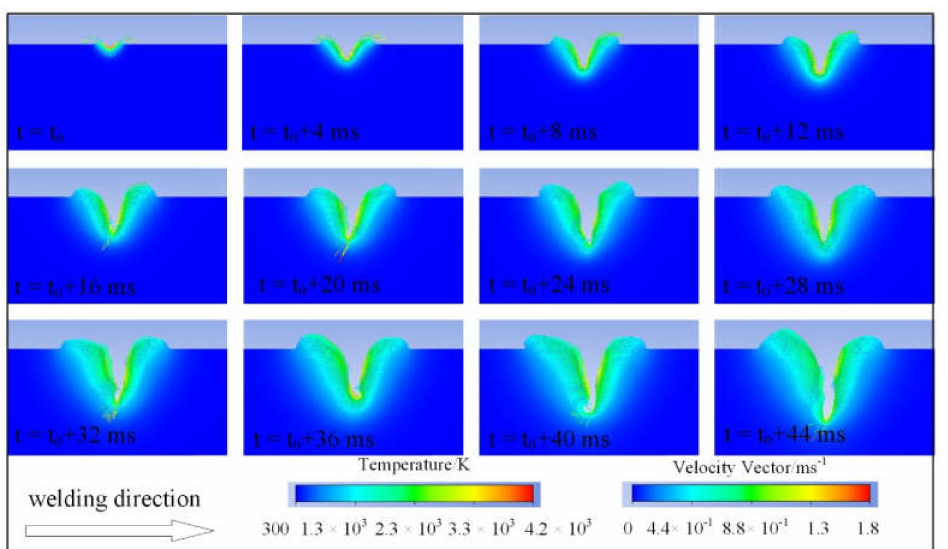
Figure 6. Keyhole formation in laser welding